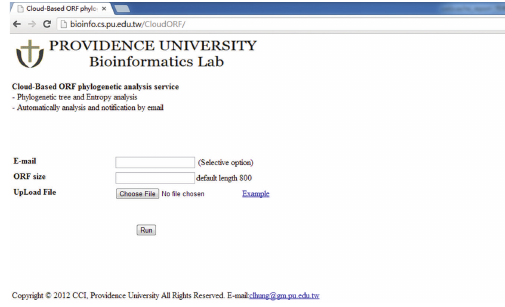
Figure 7: Portal of cloud-based ORF phylogenetic analysis service.